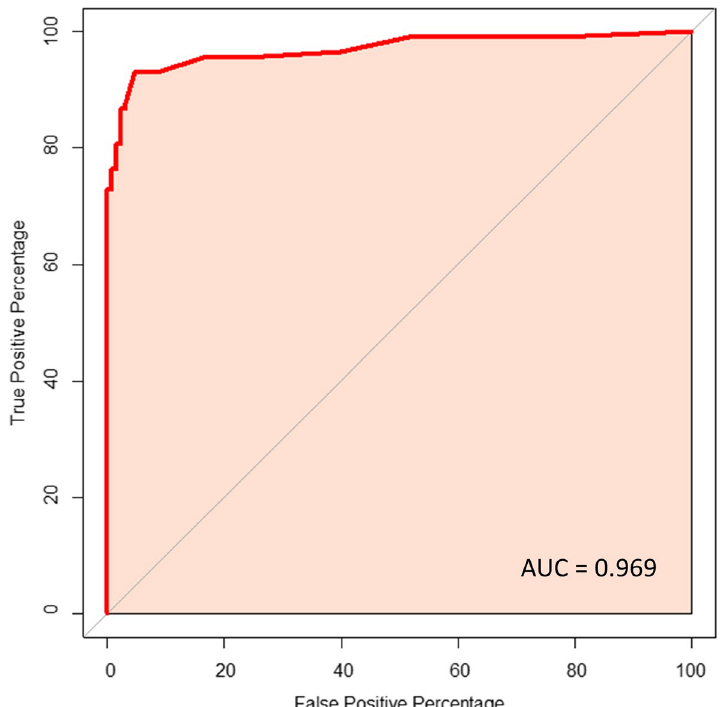
Fig. 2 The Receiver Operating Characteristic (ROC) curve for Ki67 and the applicability of this marker in the differential diagnosis between HGSC and